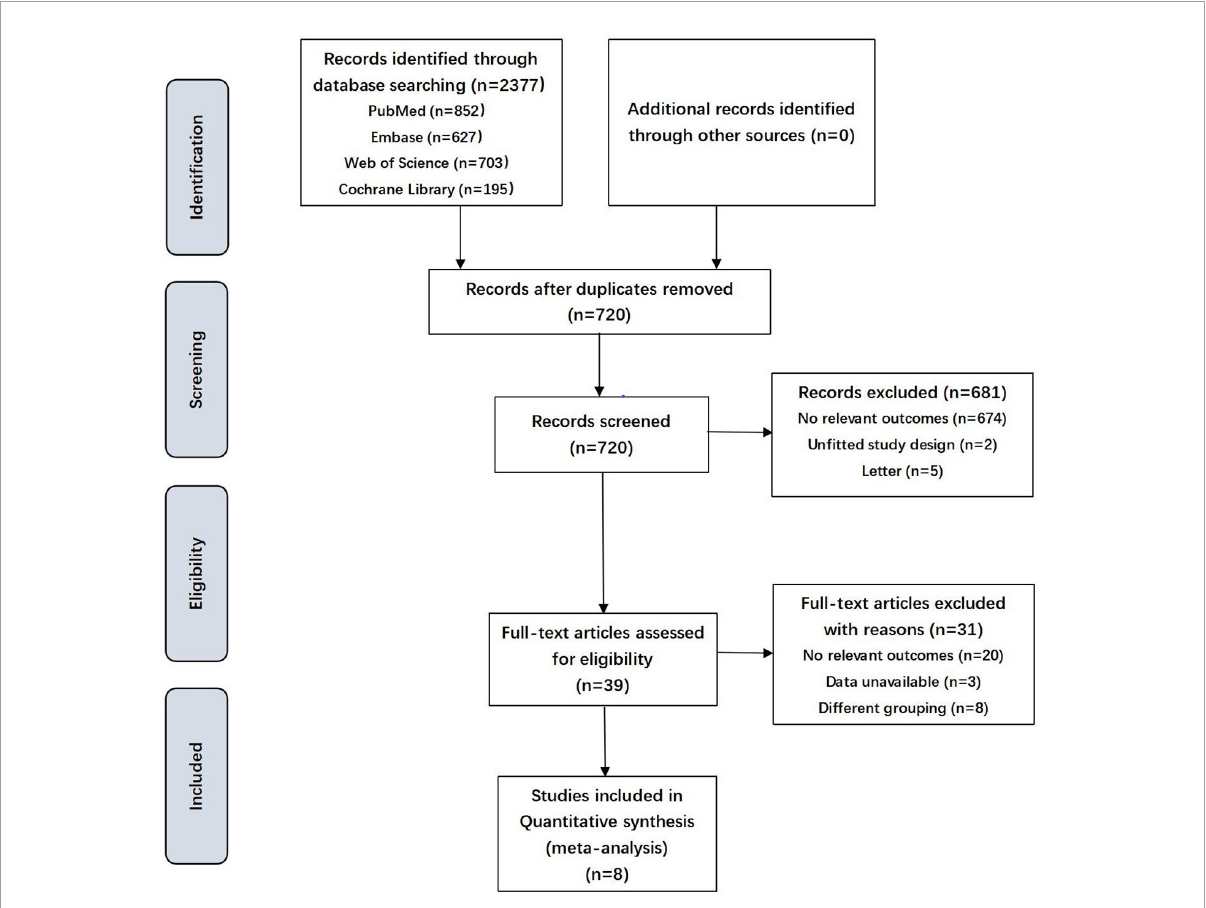
FIGURE1 Flowchart showing the selection process of the included studies. SGA, small for gestational age.